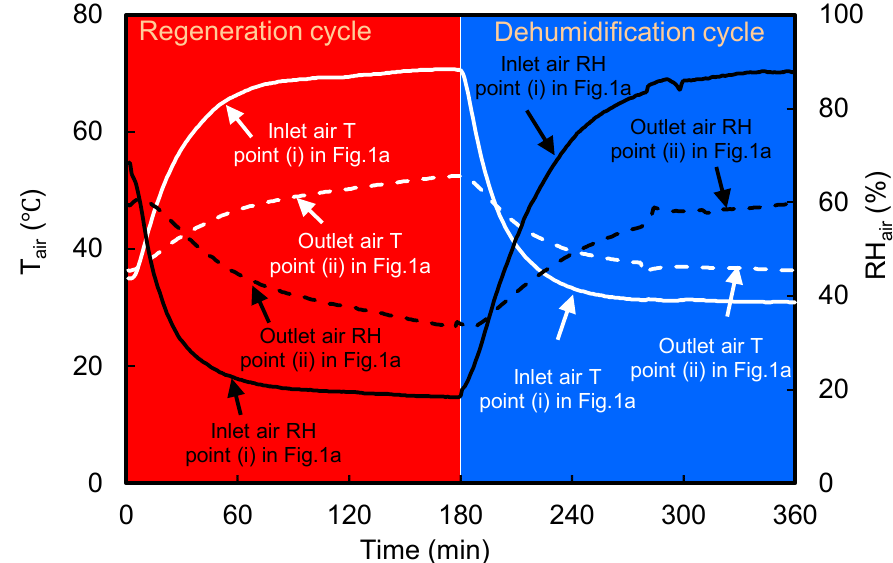
Figure 3. Regeneration and dehumidification cycle profiles of the DAC system at 70 °C regeneration temperature.